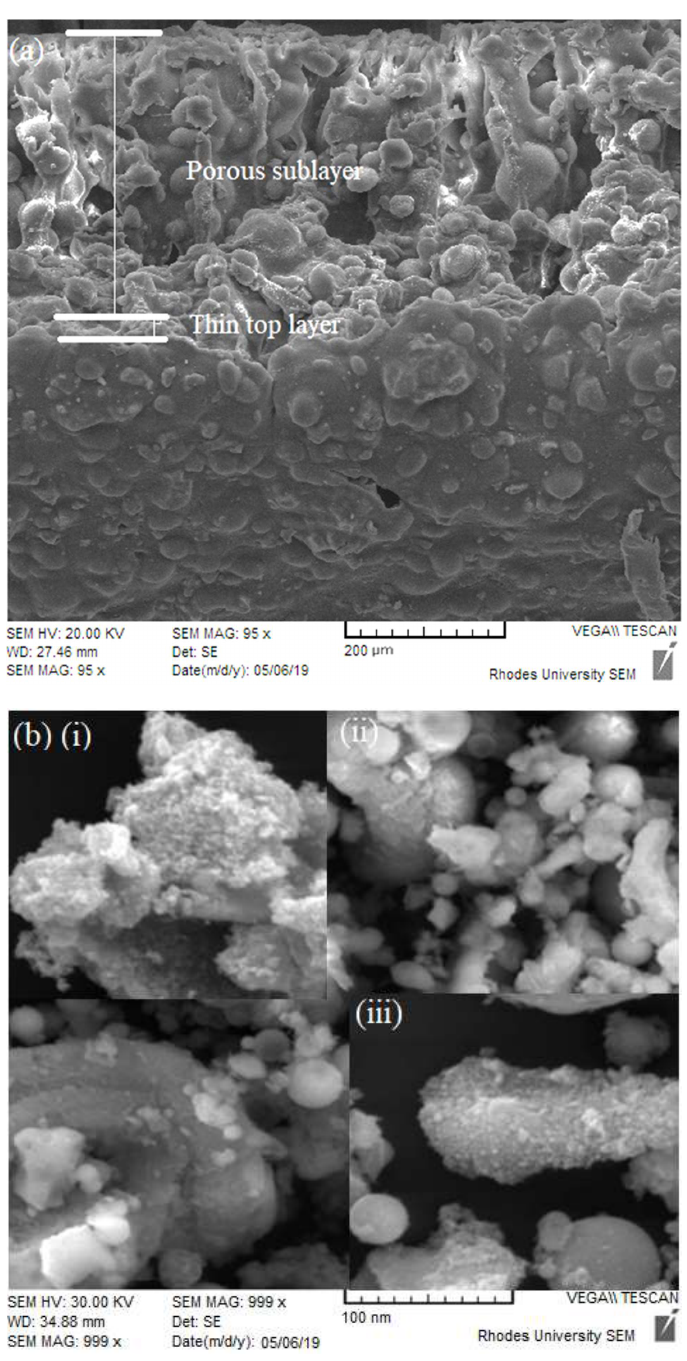
Figure 3. SEM images of ( a ) C-TiO 2 -CFA / PAN membrane and ( b ) ( i ) C-TiO 2 , ( ii ) CFA, ( iii ), and C-TiO 2